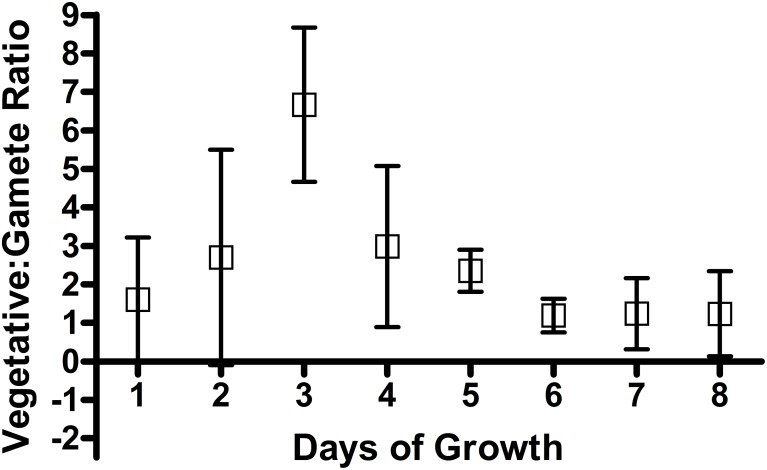
Vegetative to gametic ratio.The ratio is based on haemocytometer counts with 95% confidence intervals shown.